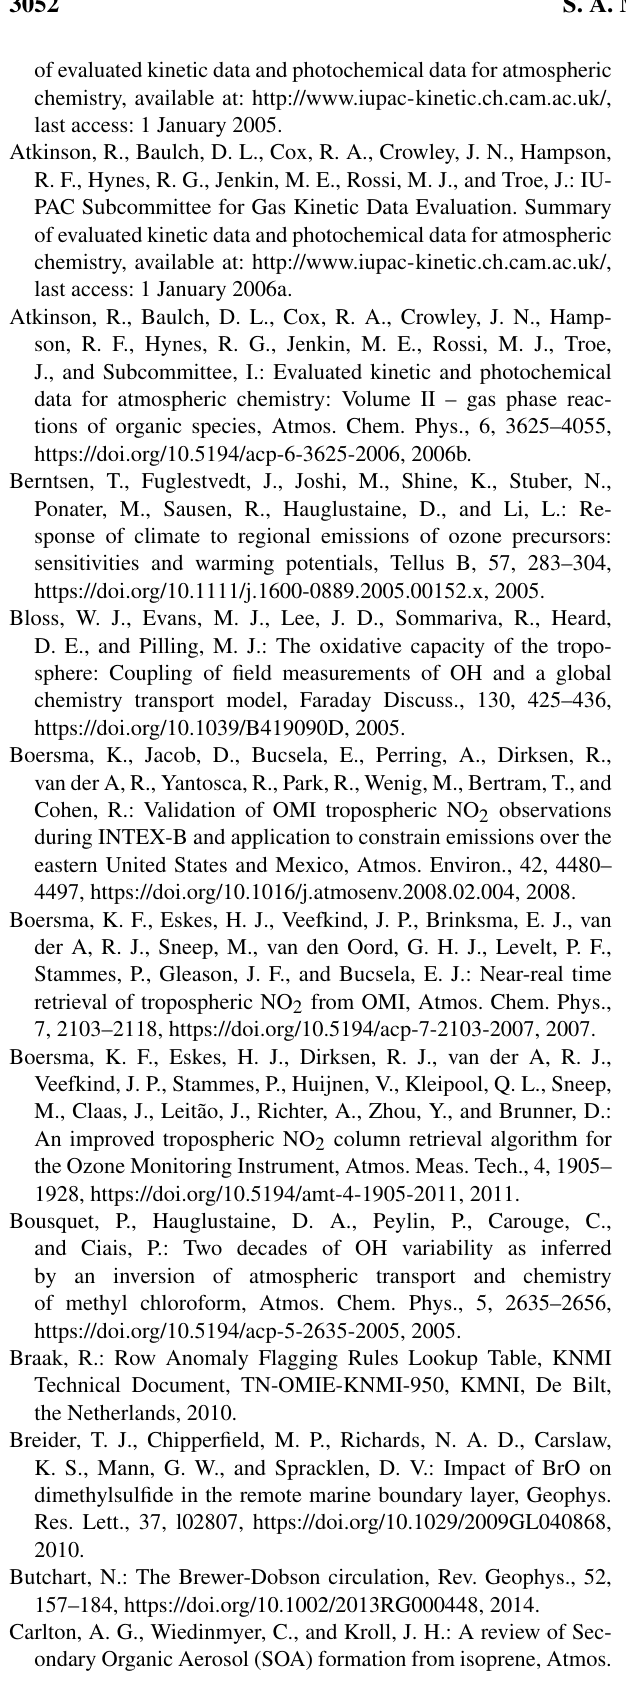
Braak, R.: Row Anomaly Flagging Rules Lookup Table,